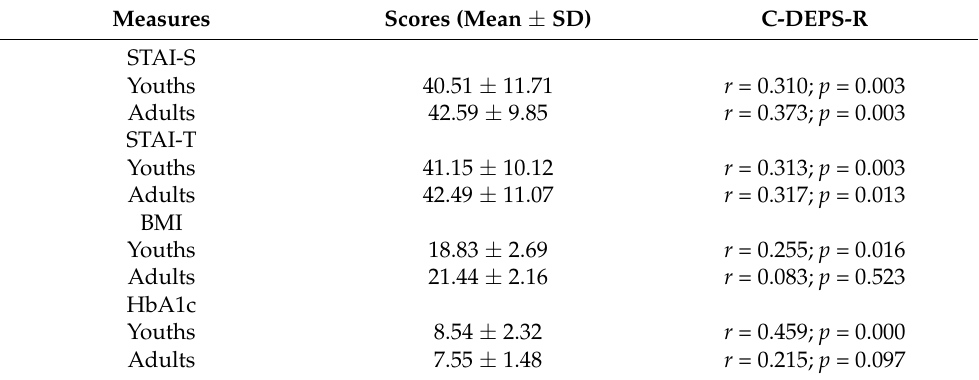
Table 5. Measures and correlations with C-DEPS-R of youths ( n = 89) and adults ( n =